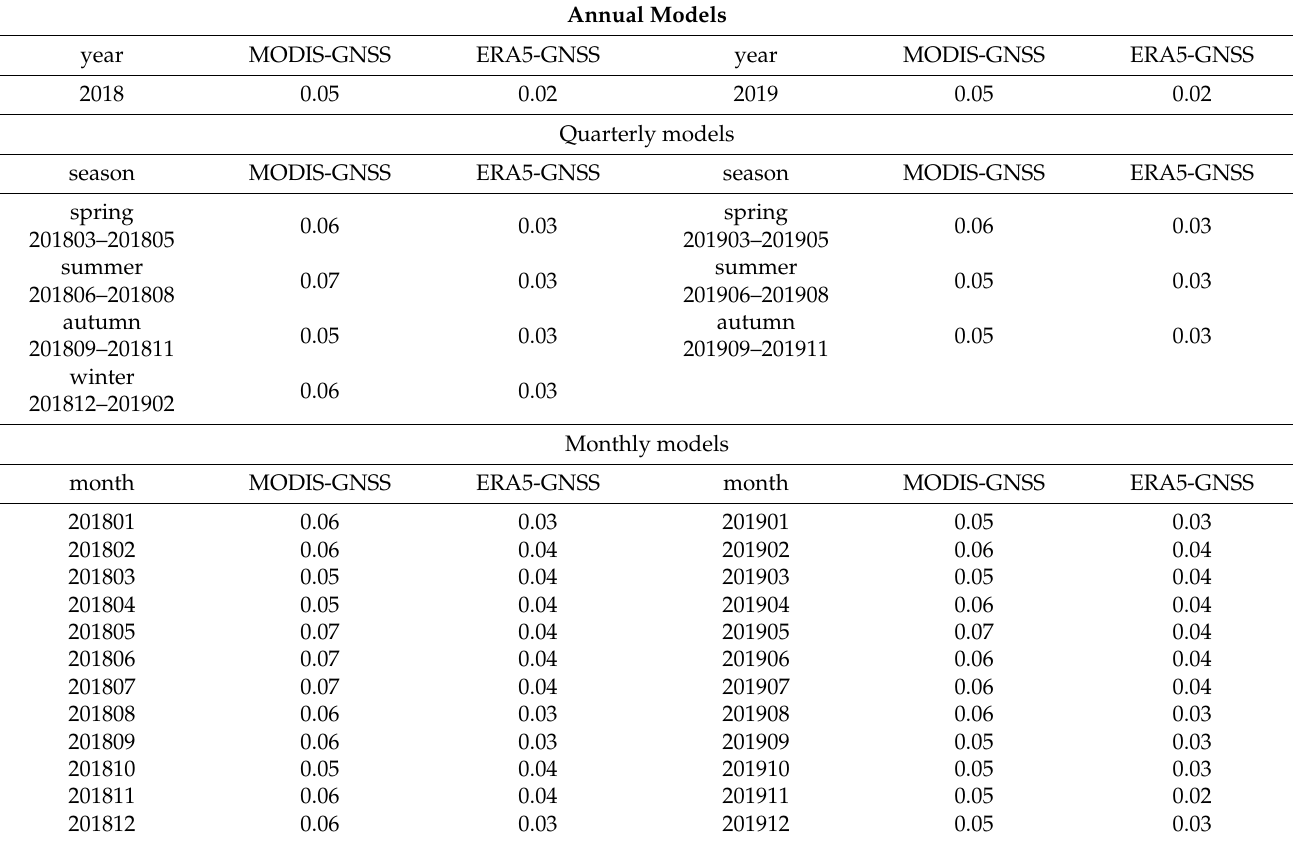
Table A1. The optimal spread parameter values of different